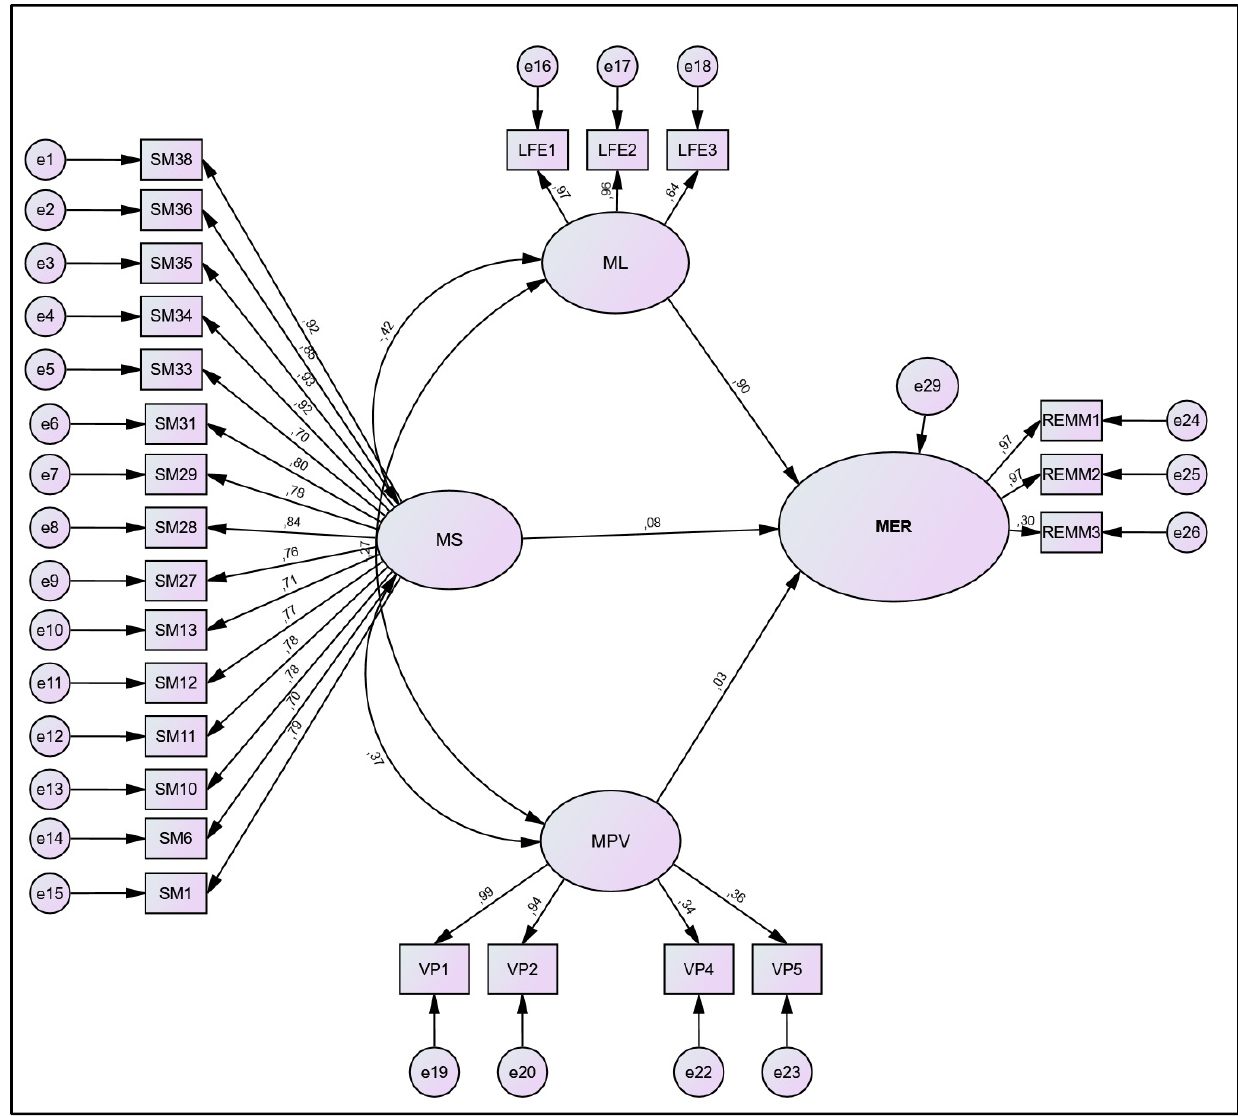
Figure 2. Final research model.